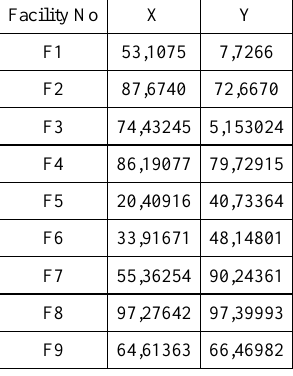
Table 1. Facilities and location